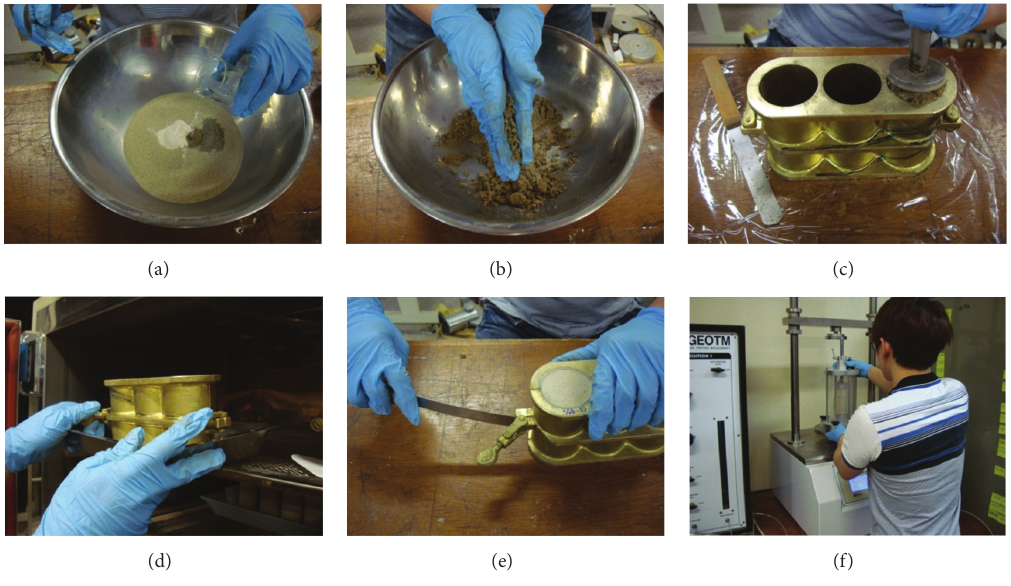
Figure 4: Mixing sample materials and producing specimens. Table 1: Mixing the sample material.